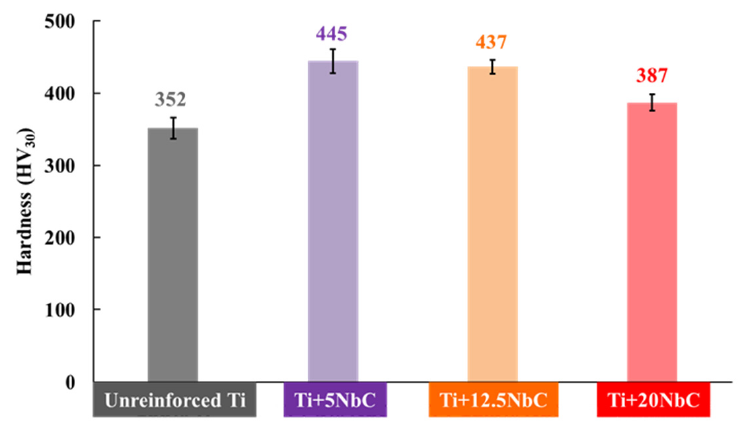
Figure 3. Vickers hardness values.